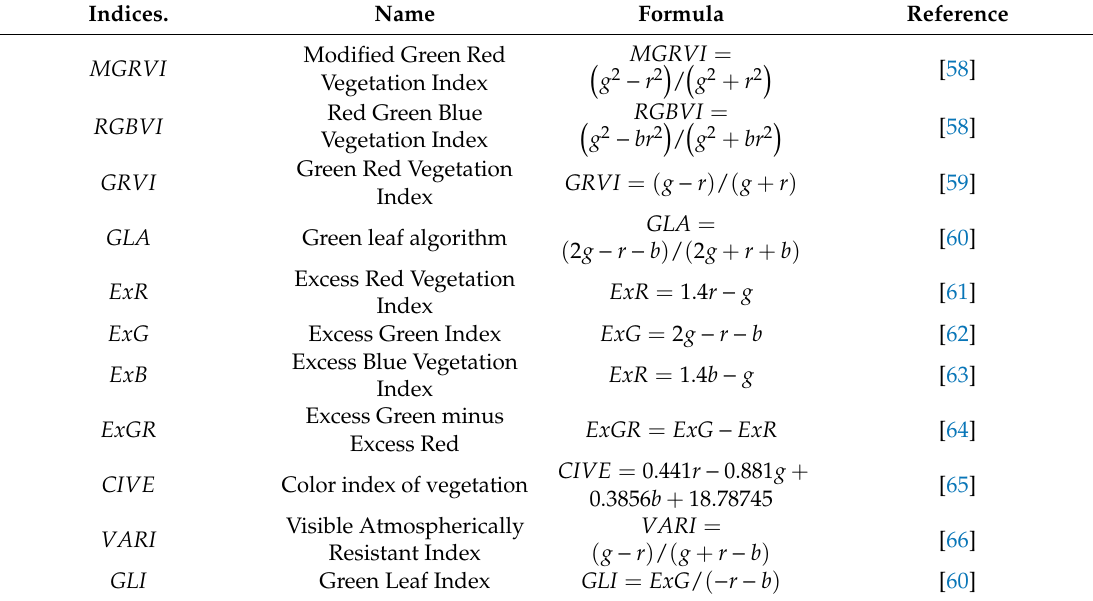
Table 1. Digital image variables related to the aboveground nitrogen